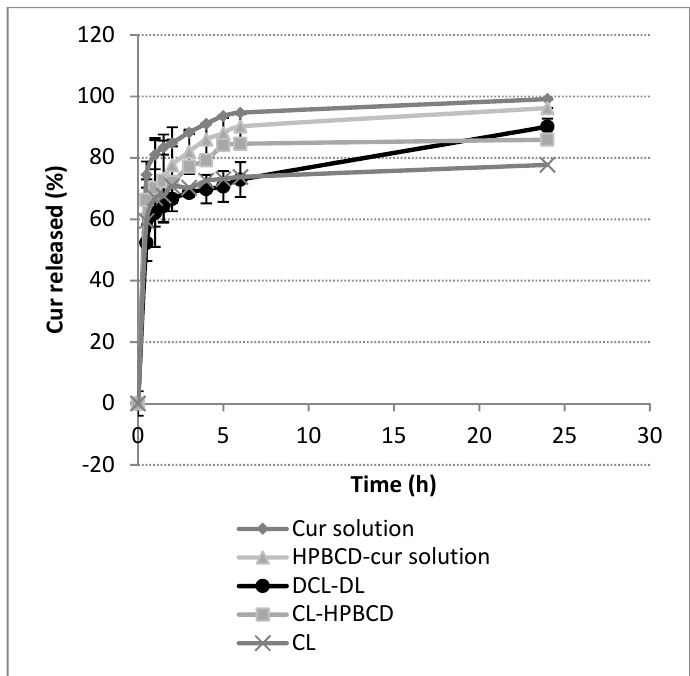
Figure 11. In vitro release profiles of hydroalcoholic Cur solution, aqueous solution of HPBCD–Cur complex, and DCL–DL formulation. Values are means with standard deviation error represented by vertical